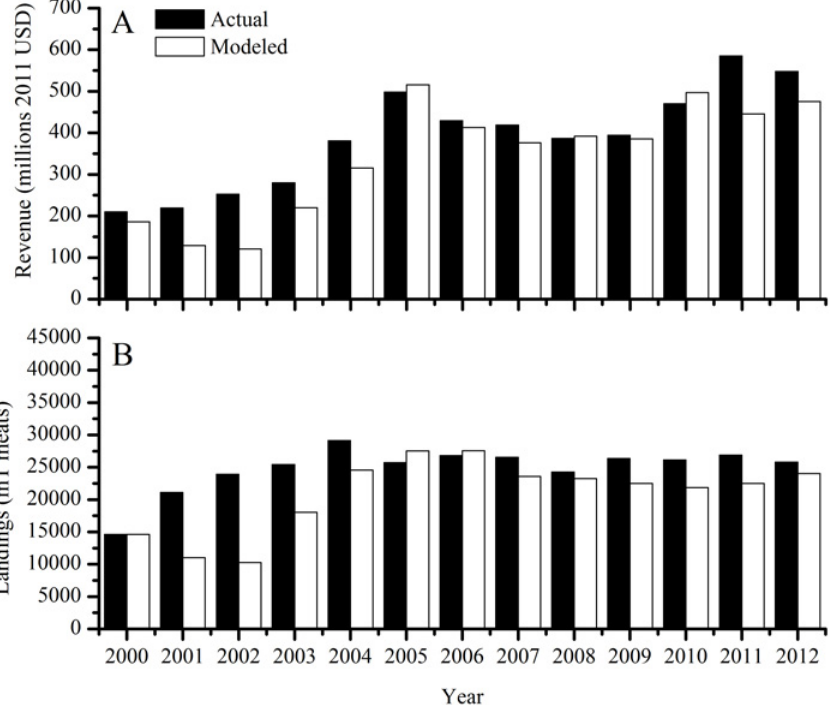
Fig 7. Actual (NMFS commercial landings accessed Jan. 28, 2014) and modeled ex-vessel (A) revenue and (B) landings. Data from year 2000 are model initial conditions.